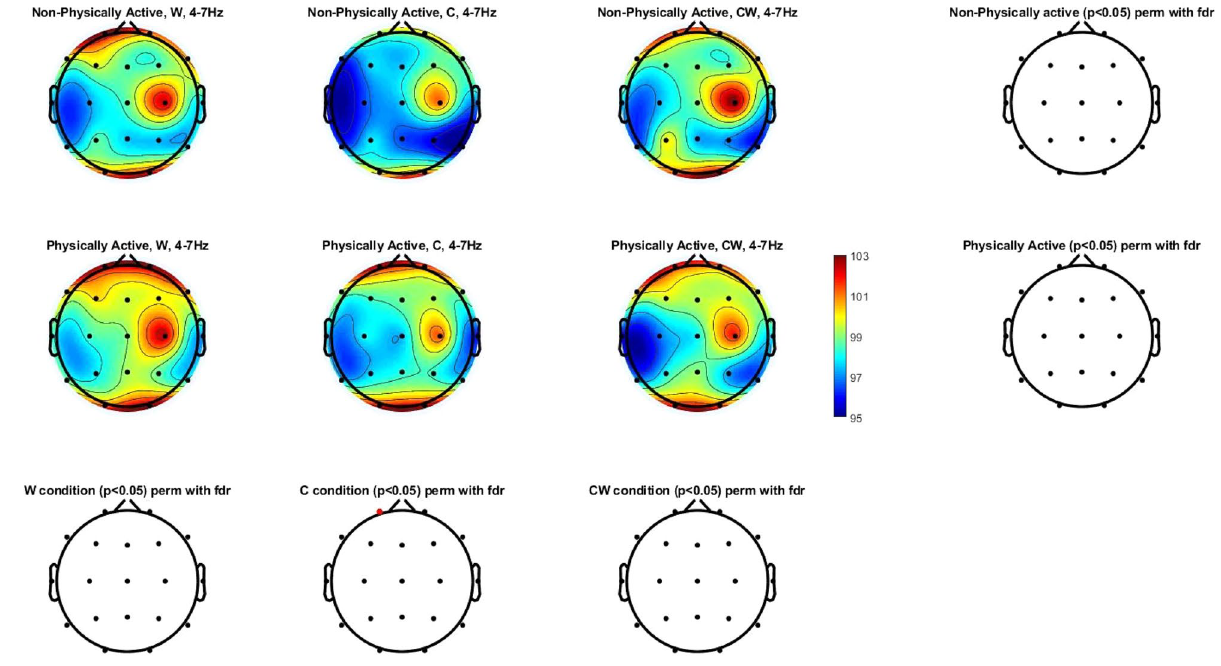
Figure 1. Theta power spectrum (4–7 Hz) topographic maps in physically and non-physically active women with FM. Differences were only located (p < 0.05, can be seen highlighted in red color) between physically and non-physically active women with FM in C condition in a frontal scalp location (Fp1). W names of colors printed in black, C names different color patches, CW names color-word, where color-word are printed in an incongruous color ink (name the color of the ink instead of reading the